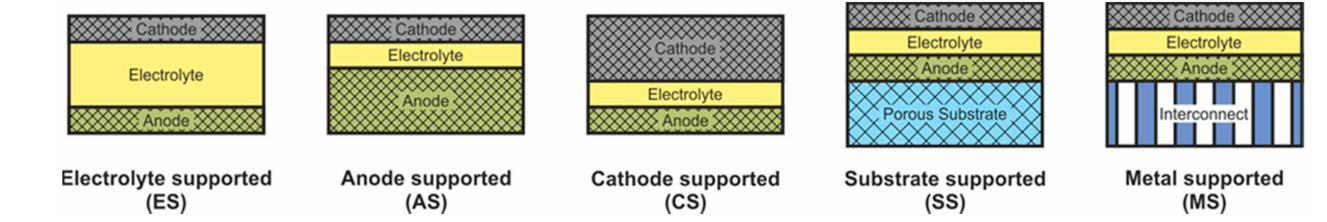
Figure 4. Different types of cell support architectures for SOFC.